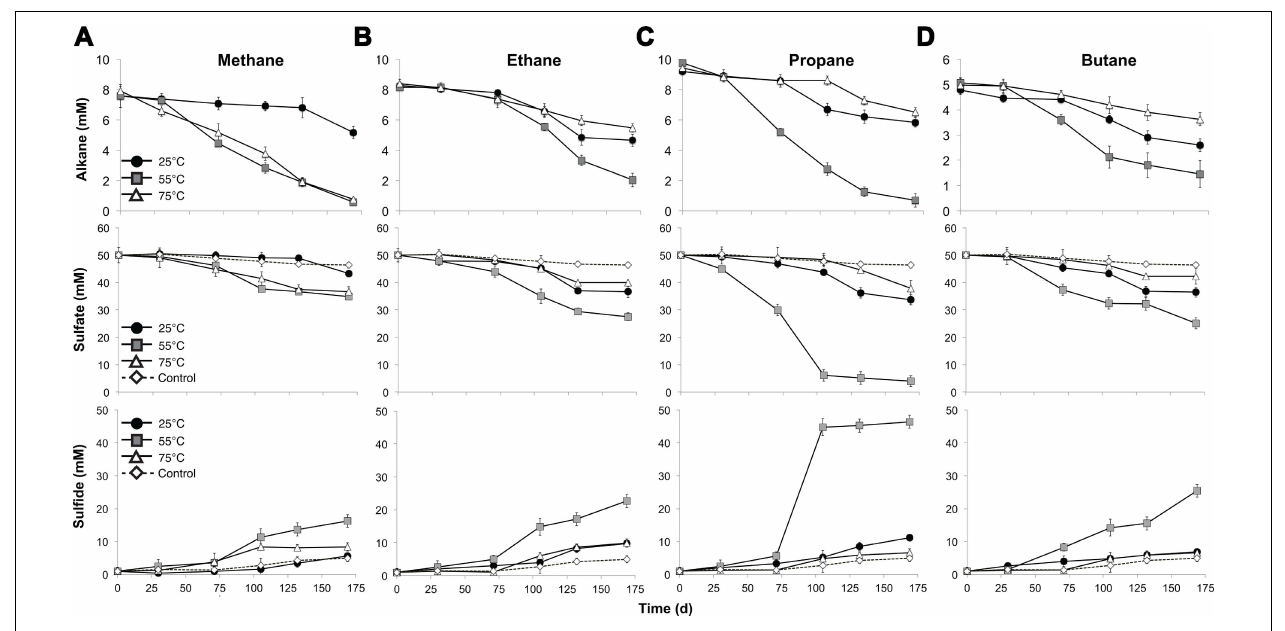
point represents the average of duplicate reactors with bars indicating the data range. For sulfate and sulfide measurements, the control in each panel represents the average sulfate consumption and sulfide production in the batch reactors with nitrogen for each incubation temperature as described in the text.